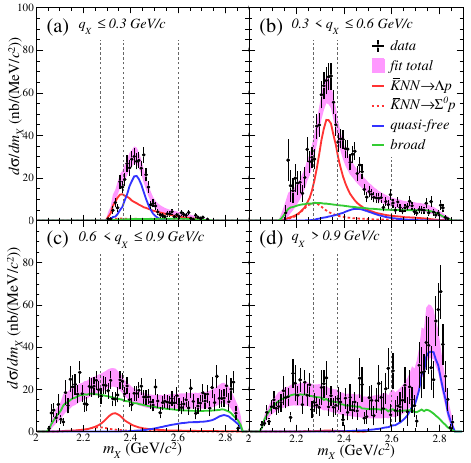
Figure 3. m X spectra with various q X intervals with the fit result. The figure was taken from Ref.